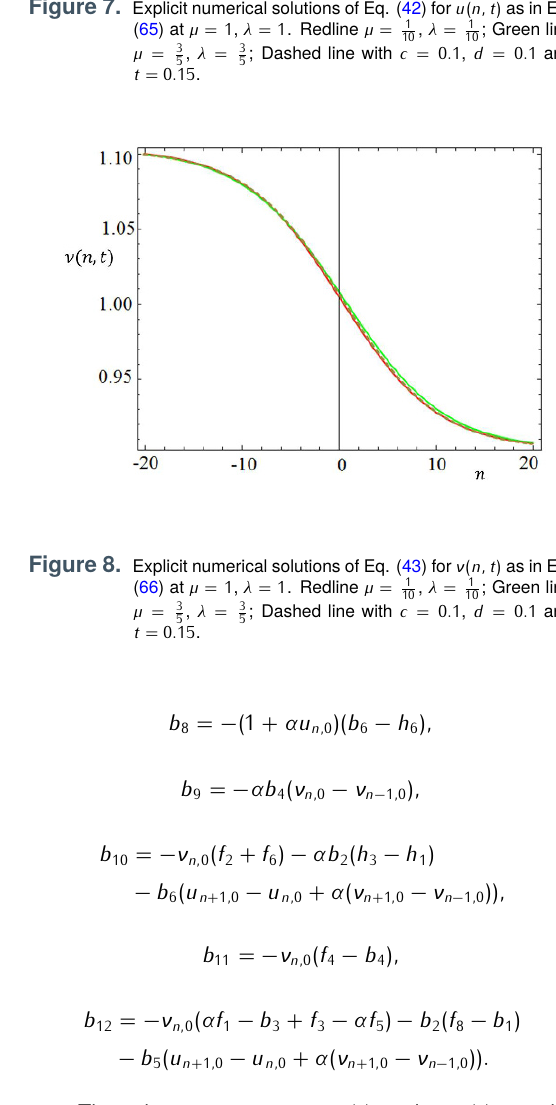
( n,t ) as in Eq. , λ = 1 ; Green line 10 10